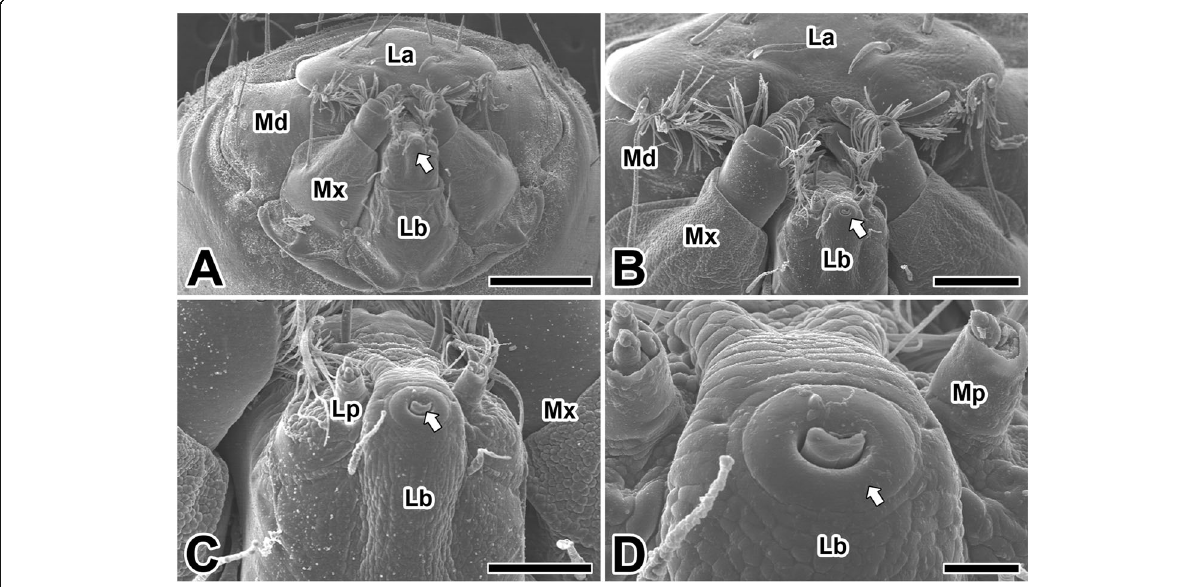
Fig. 1 a - d Scanning electron micrographs of the mouthparts in the caddisworm H. nigrovittatus. Arrow indicates spinneret of caddisworm, Md: mandible, Mx: maxilla, La: labrum, Lb: labium, Lp: labial palp, Mp: maxillary palp. Scale bars indicate 500 μ m ( a ), 200 μ m ( b ), 100 μ m ( c ), and 25 μ m ( d ),